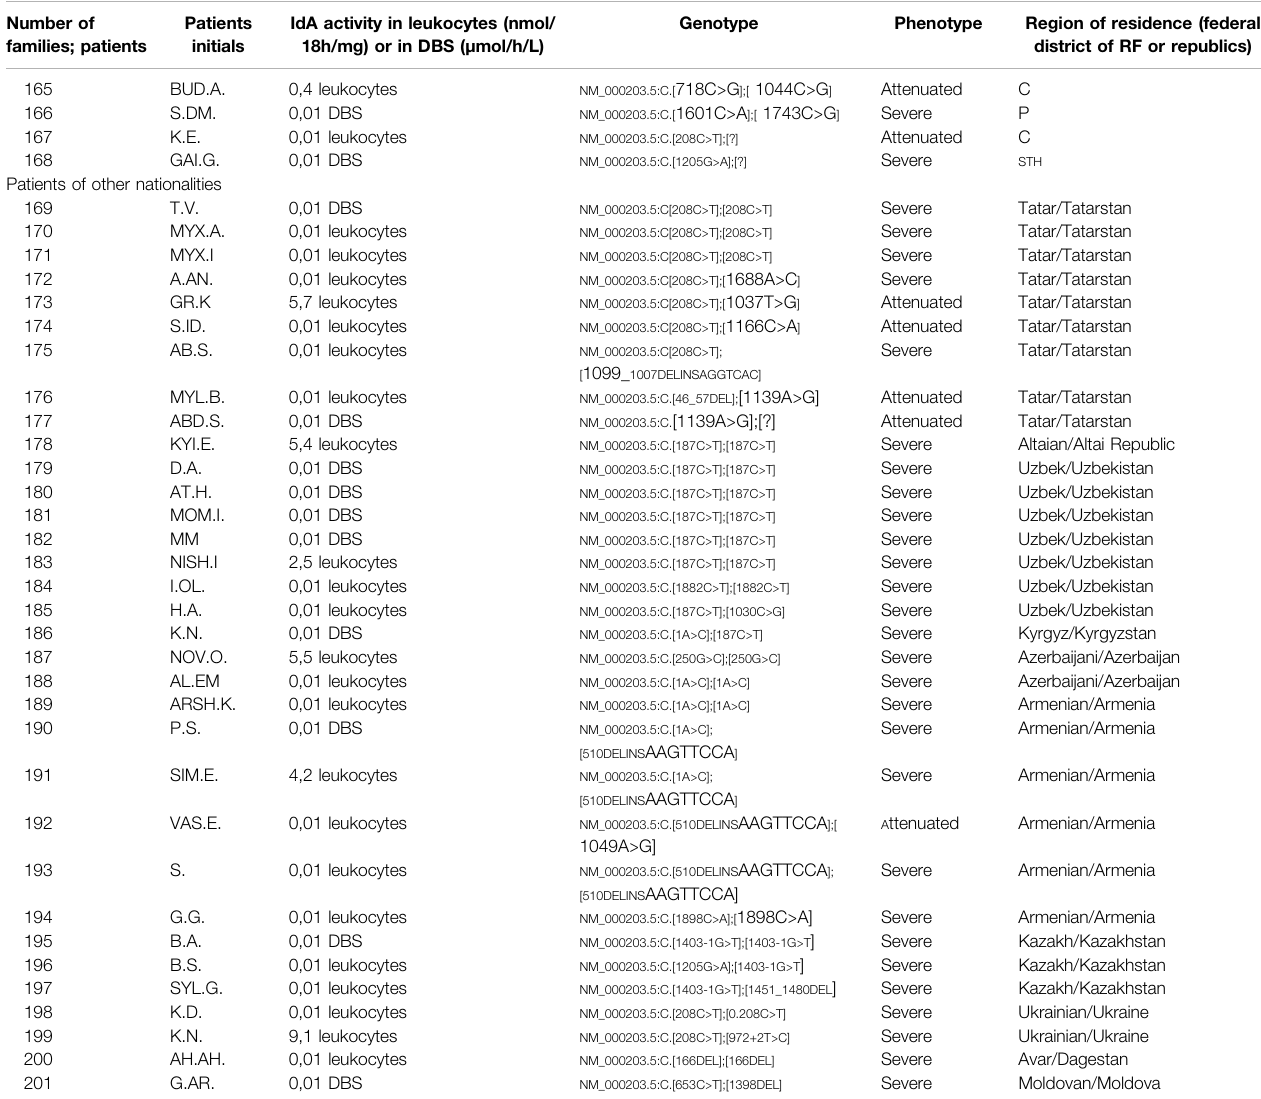
TABLE 1 | ( Continued ) Genotype and phenotype of patients with an indication of the place of residence and